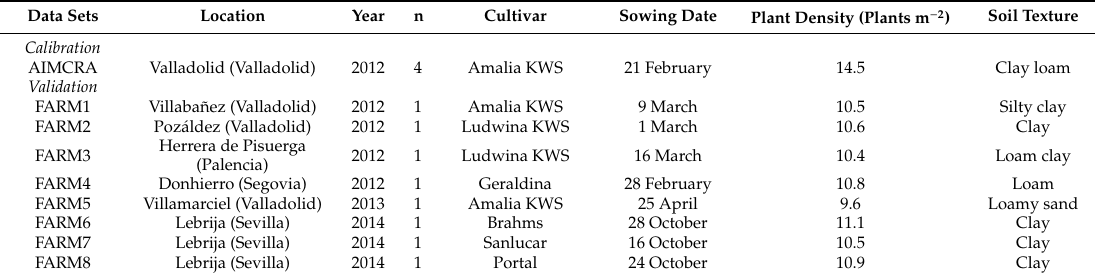
Table 1. Experimental data sets and farmers’ fields measurements used for the calibration and validation of AquaCrop for sugar beet. n is the number of irrigation